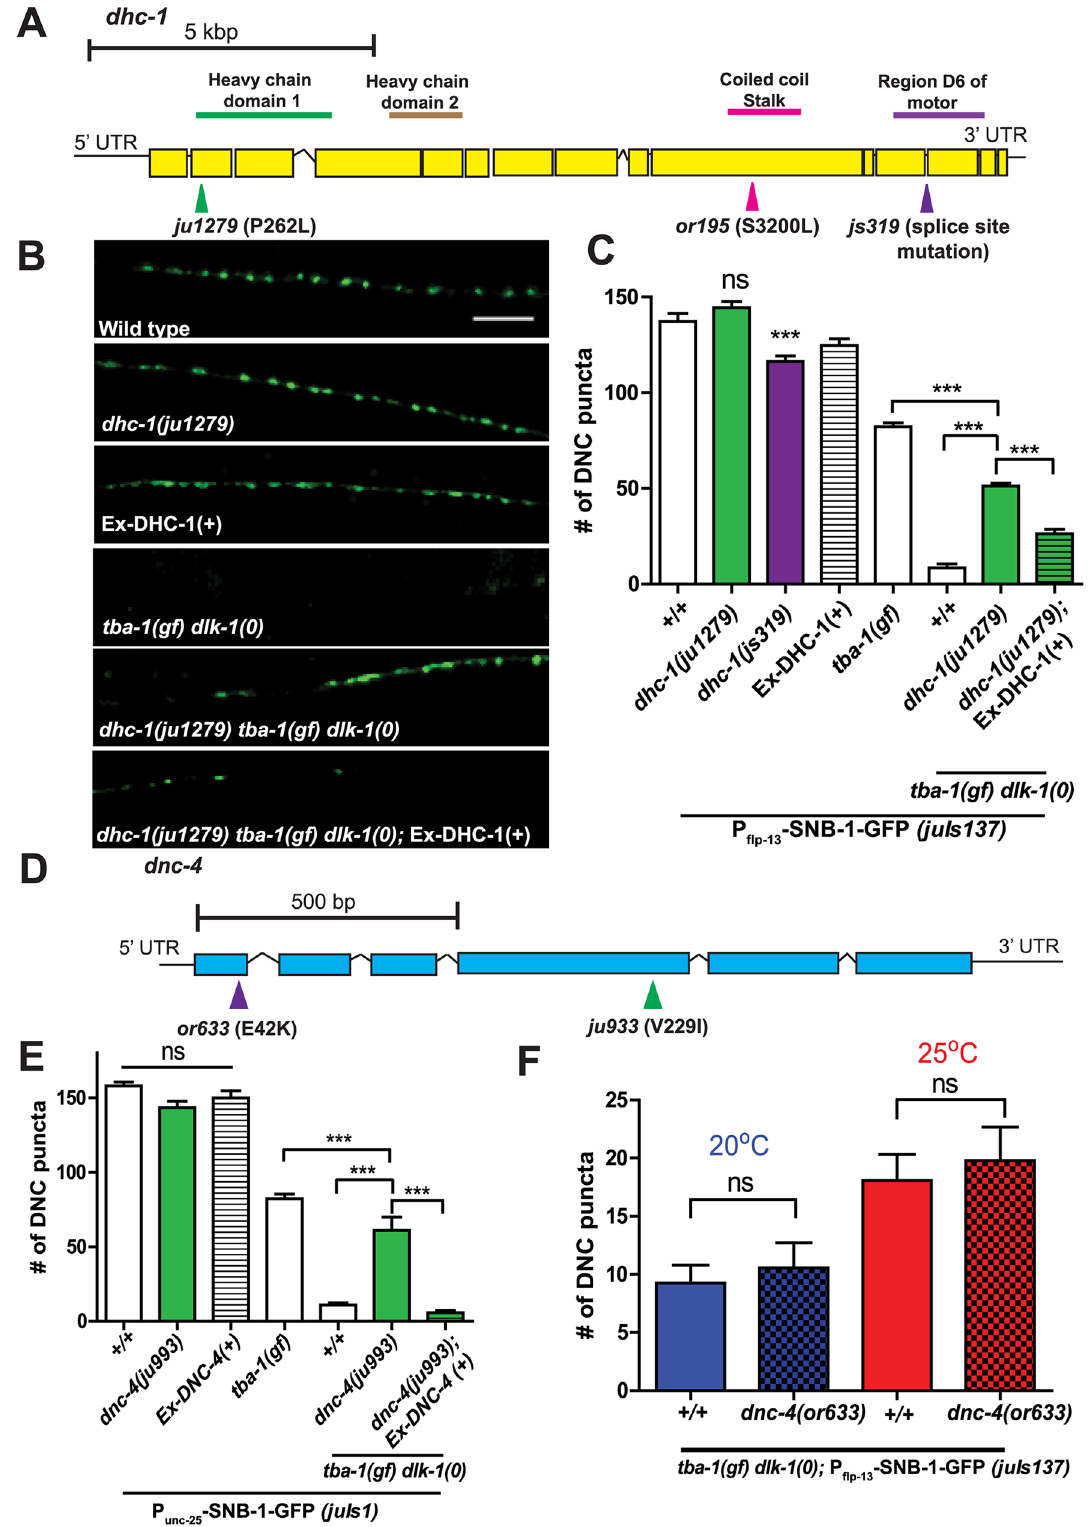
Fig 2. ju1279 and ju993 are novel alleles of dhc-1 and dnc-4 , respectively. (A) Gene structure of dhc-1 , with ju1279 and reference alleles or195 and js319 marked. ju1279 alters the N-terminal Heavy chain domain1, or195 alters the